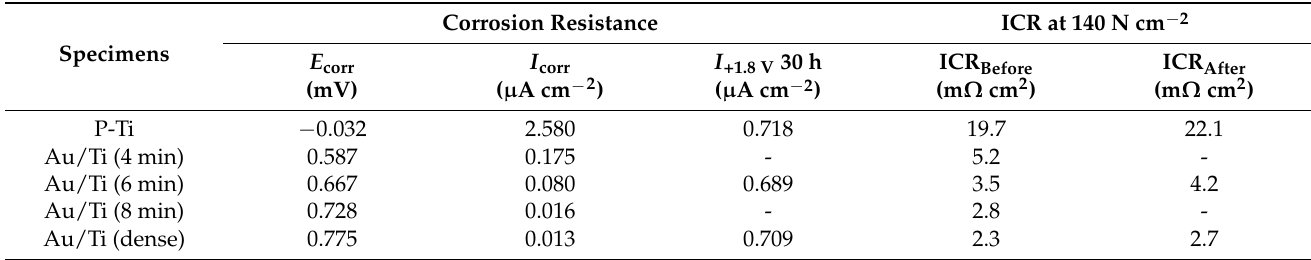
Figure 4. ( a ) Relationship between ICR and the compaction force, ( b ) ICR at 140 N cm − 2 of the P-Ti and the Au/Ti prepared with different electrical pulse times. Table 1. Corrosion resistance and ICR of the different